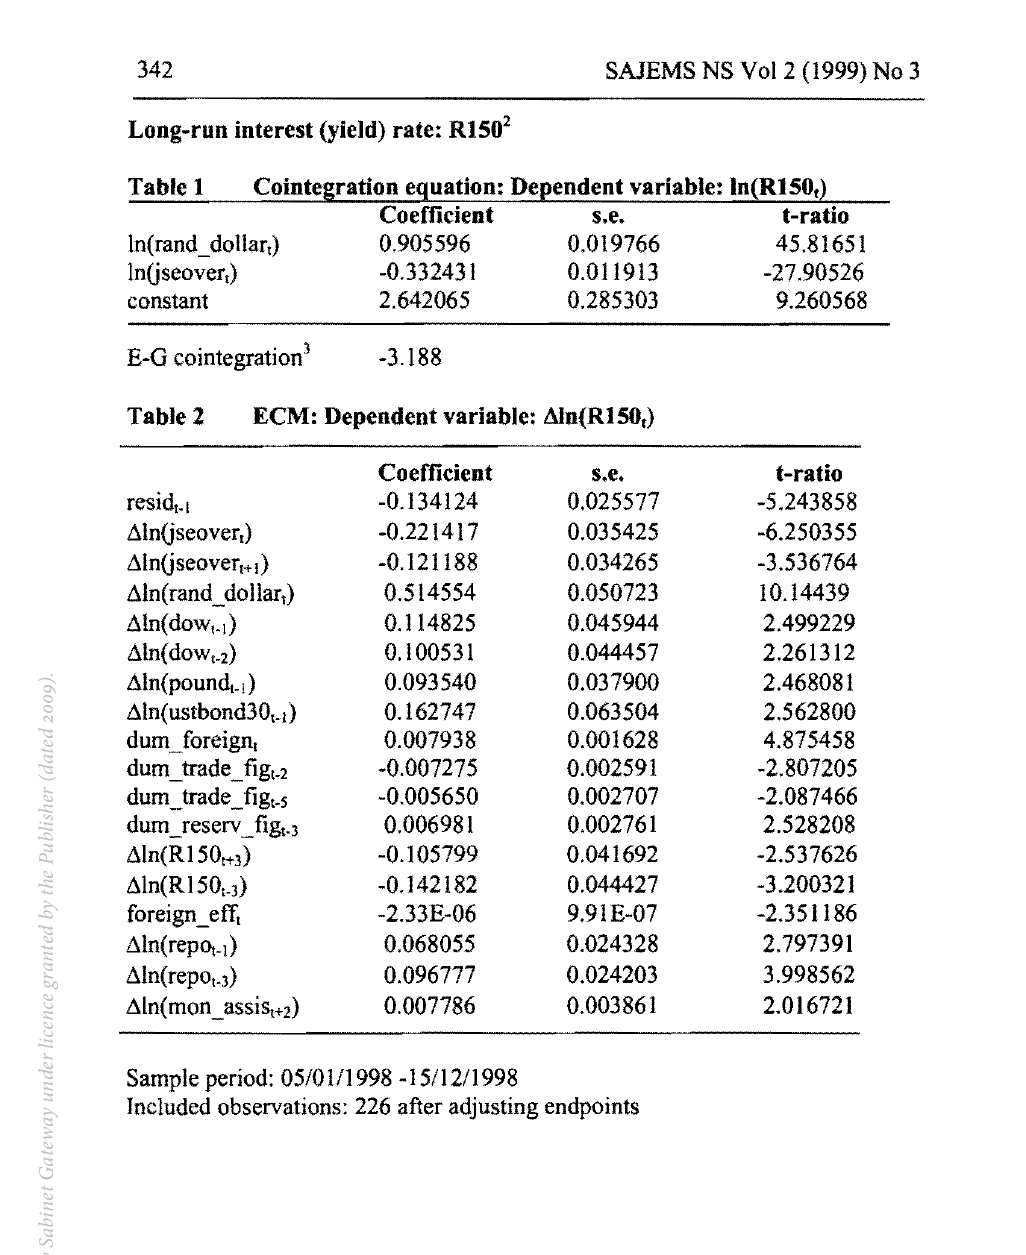
Cointegration equation: Dependent variable: In(RlSO